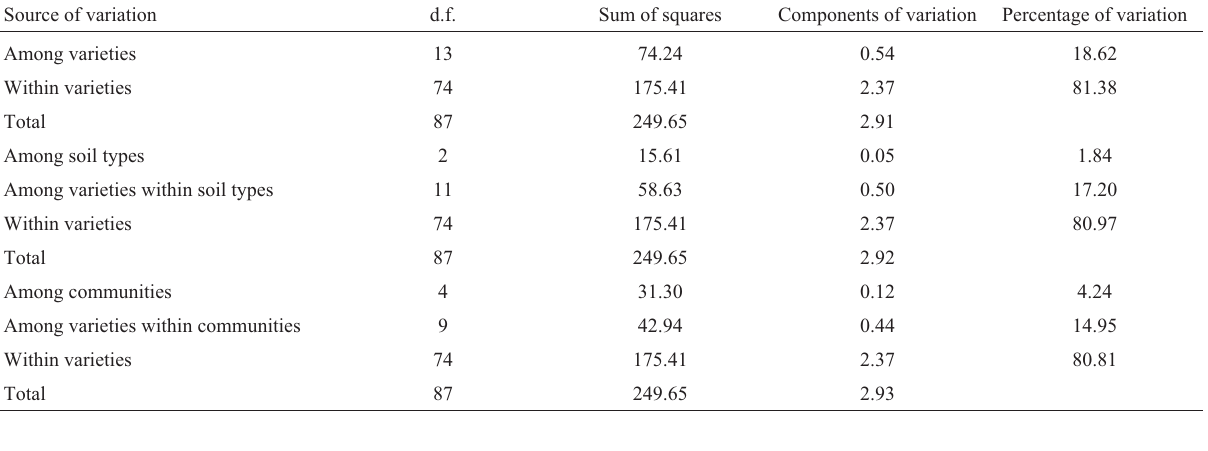
Table4 -Analysisofmolecularvarianceforhierarchicalgroupingsof14bittermaniocvarietiesgrowninADE,Oxisolsandfloodplainsoilsincommuni- ties in Manicoré, Amazonas, Brazil. The levels analyzed were: among the varieties; among varieties within soil types; among varieties within communi- ties. d.f. = degrees of